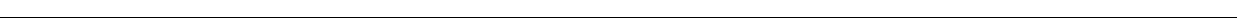
Figure 1 | BPTF is required for c-MYC transcriptional activity. ( a ) Immunofluorescence staining of BPTF and c-MYC showing MYC-ER nuclear translocation upon 4-OHT treatment in control and BPTF-silenced HFF. Scale bar, 25 m m ( b ) Examples of expression of known c-MYC target genes, analysed by RT–qPCR, upon BPTF knockdown. Transcript levels were normalized against GAPDH and the vehicle-treated condition. Data are expressed as mean ± s.e.m. ( n Z 3). P values were determined using an unpaired t -test. ( c ) Fold change in FPKM values of c-MYC-dependent gene sets enriched in 4- OHT-treated control cells. Values are displayed for both control and BPTF-silenced HFF MYC-ER cells. Gene sets tested and P values (Wilcoxon test): 1, Schuhmacher et al. ‘MYC targets up’ ( P ¼ 3.156 (cid:2) 10 (cid:3) 15 ); 2, Acosta et al. ‘proliferation independent MYC targets up’ ( P ¼ 2.034 (cid:2) 10 (cid:3) 08 ); 3,